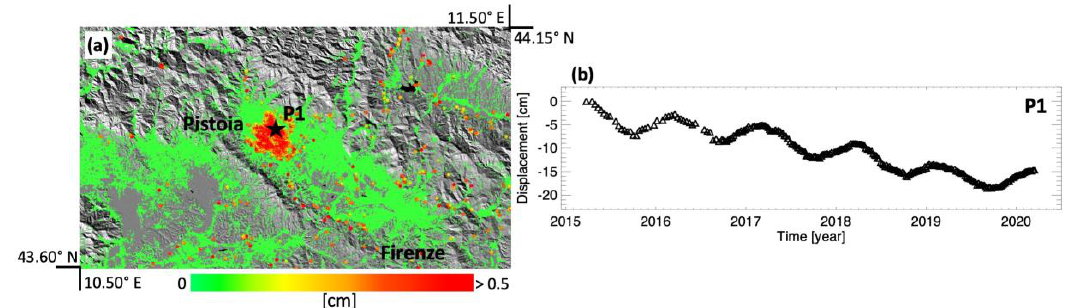
Figure 18. Correlation map between the DInSAR time series and an annual sinusoid relevant to the Firenze-Prato-Pistoia basin (North Italy). ( a ) Peak-to-peak oscillation amplitude map superimposed on the SRTM DEM of the zone. Note that pixels with peak-to-peak amplitude values equal to 0 are those for which the correlation coefficient is smaller than 0.8. ( b ) Displacement time series relevant to the pixel P1, marked by the black star in the map, located in correspondence of the maximum deforming zone.